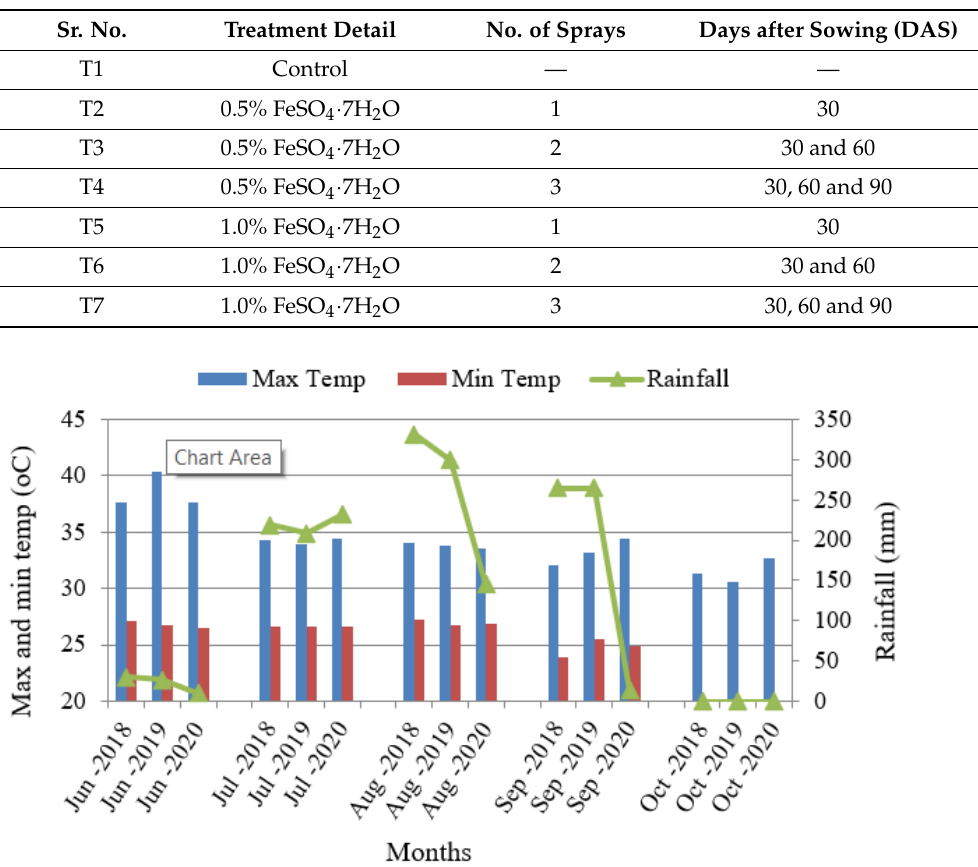
Table 1. Treatment details of experiment at research farm of PAU Ludhiana.